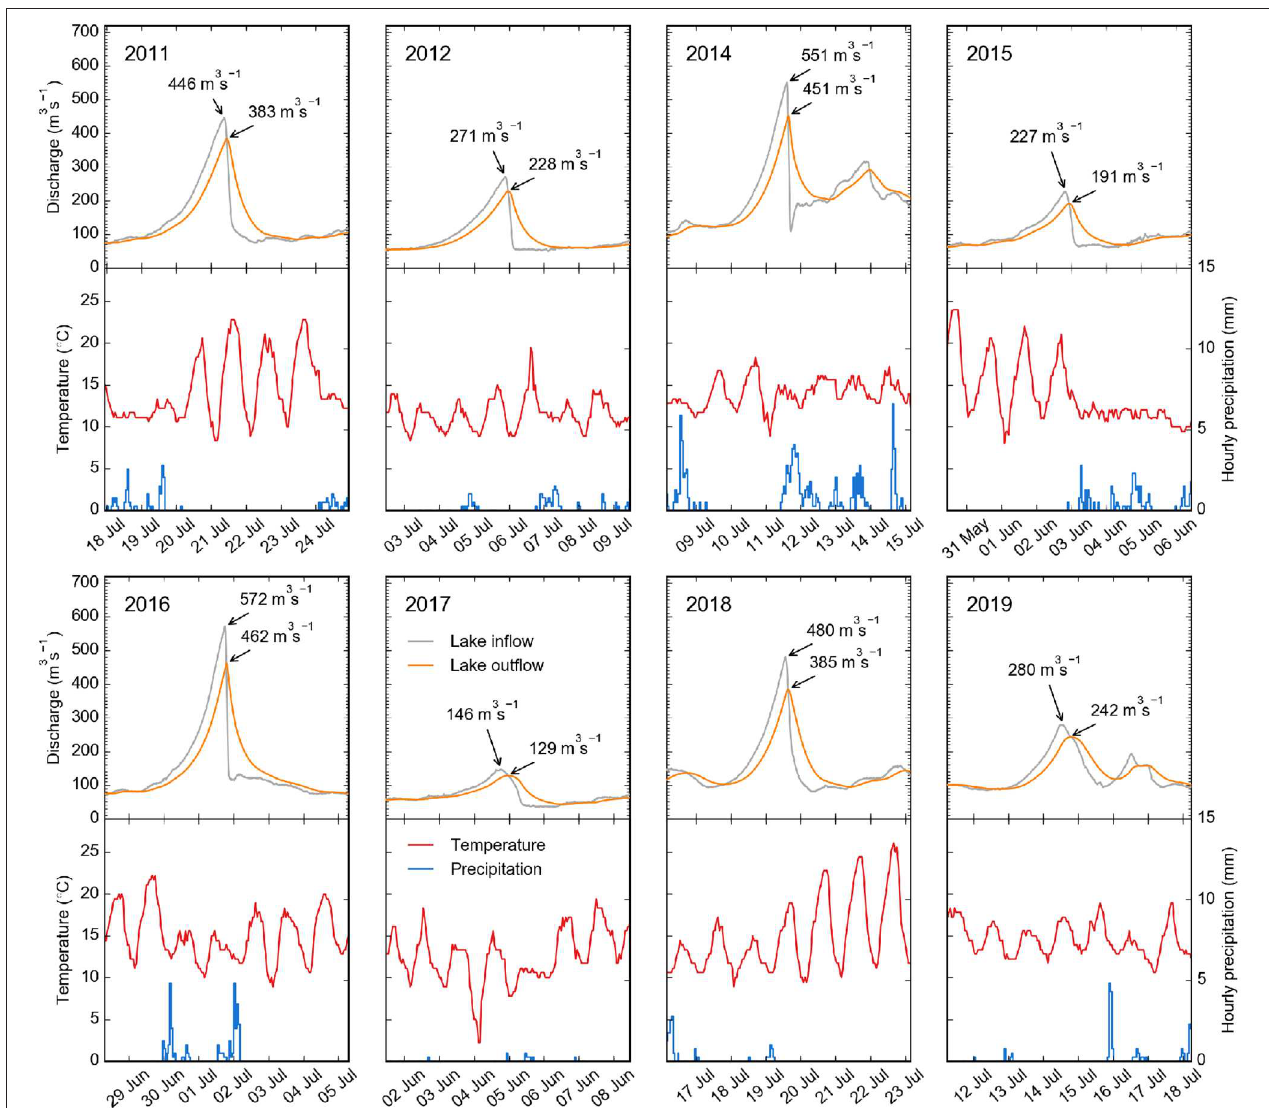
FIGURE 2 | Main GLOF events observed between 2011 and 2019 at Mendenhall Lake and Mendenhall River. There is no panel for the 2013 event, which featured early and slow lake drainage at Suicide Basin, with no distinguishable reaction at Mendenhall Lake. (Top) panels show Mendenhall Lake inflow (gray lines) and outflow (orange lines). (Bottom) panels show the corresponding meteorological variables measured at Juneau Airport. The Mendenhall Lake outflow, which corresponds to the Mendenhall River discharge, is derived from the Mendenhall Lake level via rating curve for USGS station 15052500 (U.S. Geological Survey, 2019). The Mendenhall Lake inflow Q in is calculated in a mass conserving fashion by differencing lake outflow Q out and changes in lake storage, Q in = Q out + A · dh / dt , where A is the lake area (a function of the water level) and dh / dt the rate of the lake level change (Bartholomaus et al., 2015). Unlike previous events, the 2019 event caused two GLOF-related discharge peaks (on 14 and 16